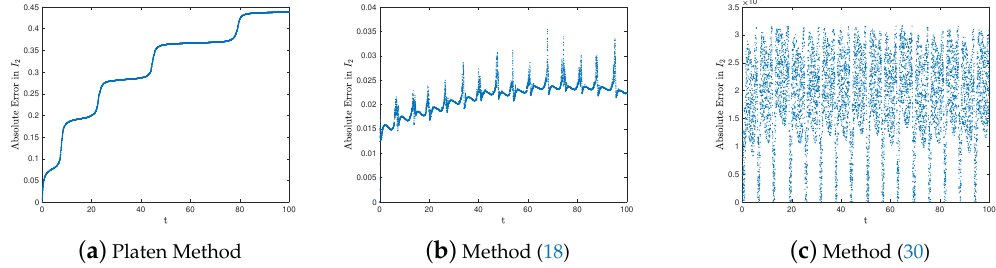
Figure 11. Conserved quantity errors in I 2 of the Platen method, method (18), and method